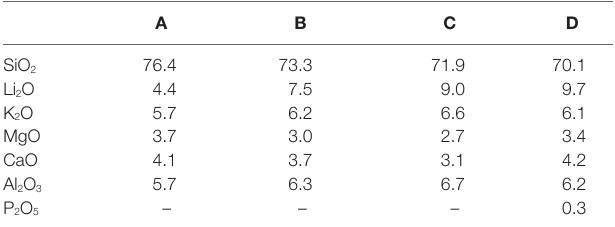
TaBle 6 | estimated chemical compositions of the residual glass phases in mol%.